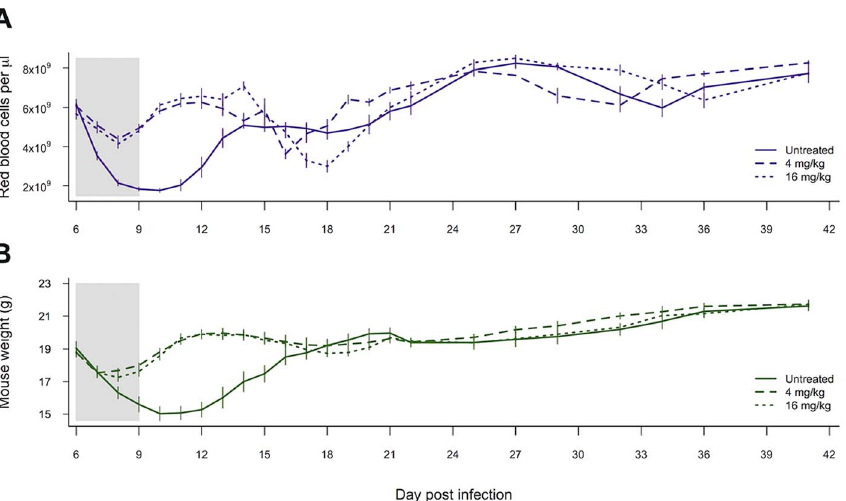
Figure 5. Drug treatment effects on measures of health. Red blood cell density (a) and weight (b) of mice left untreated, given 4 mg/kg of artesunate or given 16 mg/kg of artesunate. Lines represent the mean from between 8 and 10 infections per treatment and bars show the standard error of the mean. The shaded area shows the period of drug treatment. Data from experiment 3.